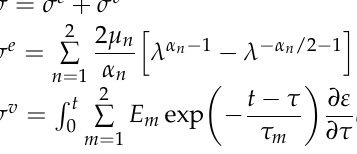
Table 2. Viscoelastic model parameters of HTPB propellant matrix film.